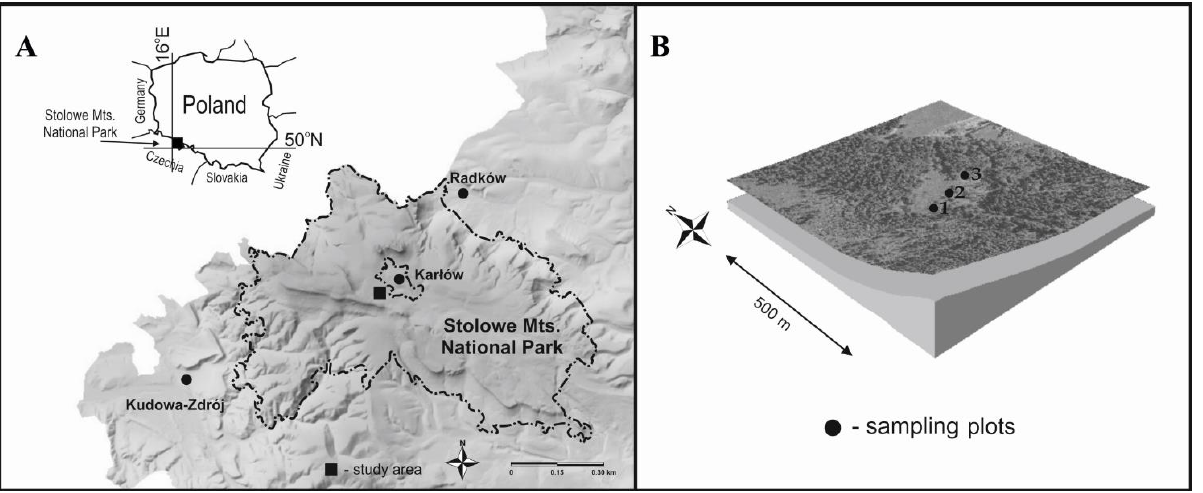
Figure 1. Location of the study area (A) and locations of the sampling plots within the research transect